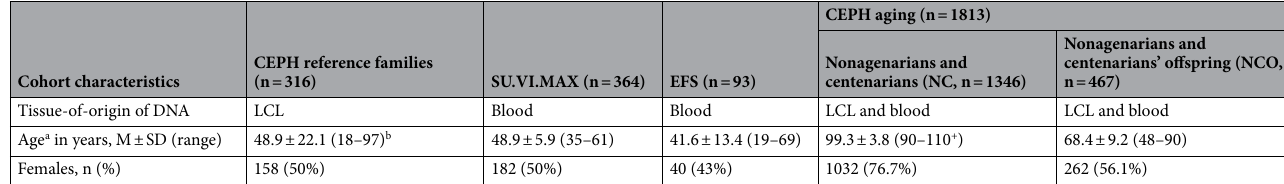
Table 1. Descriptive statistics of the DNA samples used from the four collections used. a Age at collection. b Known for 214